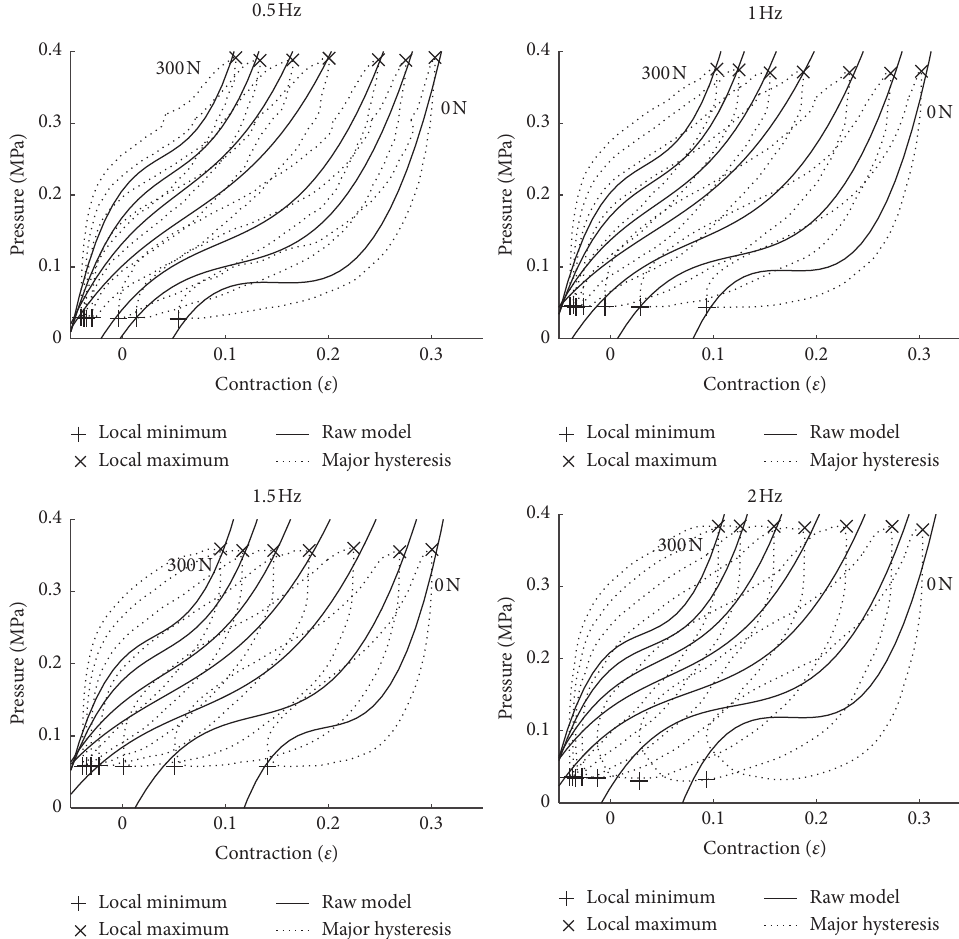
Figure 4: Identification of local maximum and local minimum of hysteresis